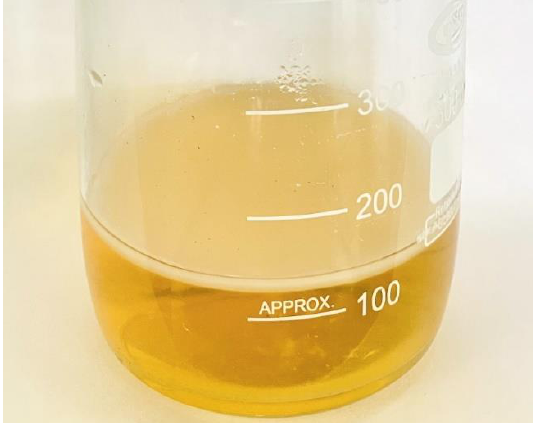
Figure 5. Picture showing bacterial growth and formation of bacterial cellulose membrane as a flo- tation promoter. Reproduced with permission from [69], Universidade Federal de Pernambuco, 2020.